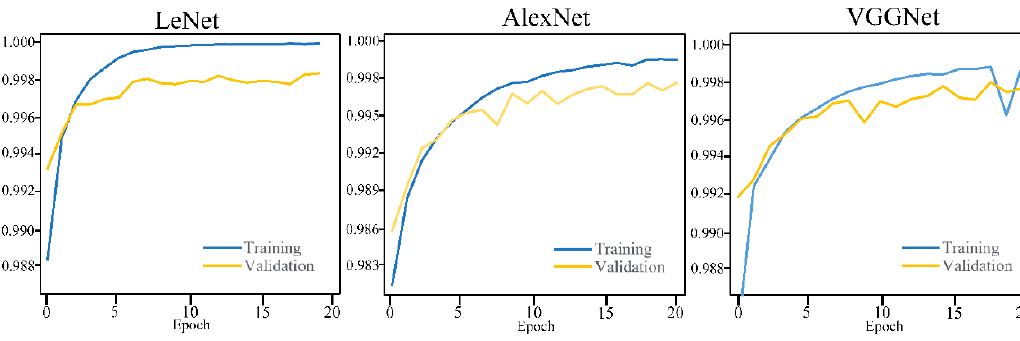
Figure 11. Accuracy of models. Blue lines represent the accuracy on training set, orange lines represent the accuracy on validation set.